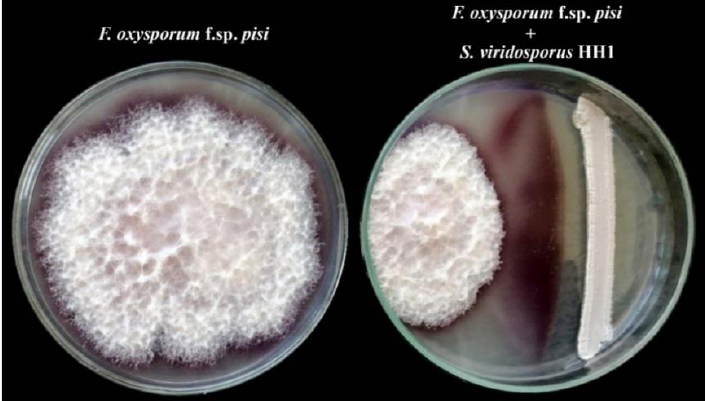
Figure 1. A dual culture test showing the antifungal activity of S. viridosporus HH1 against F. oxysporum f.sp. pisi. Table 2. Secondary metabolites produced by S. viridosporus HH1 identified using GC-MS